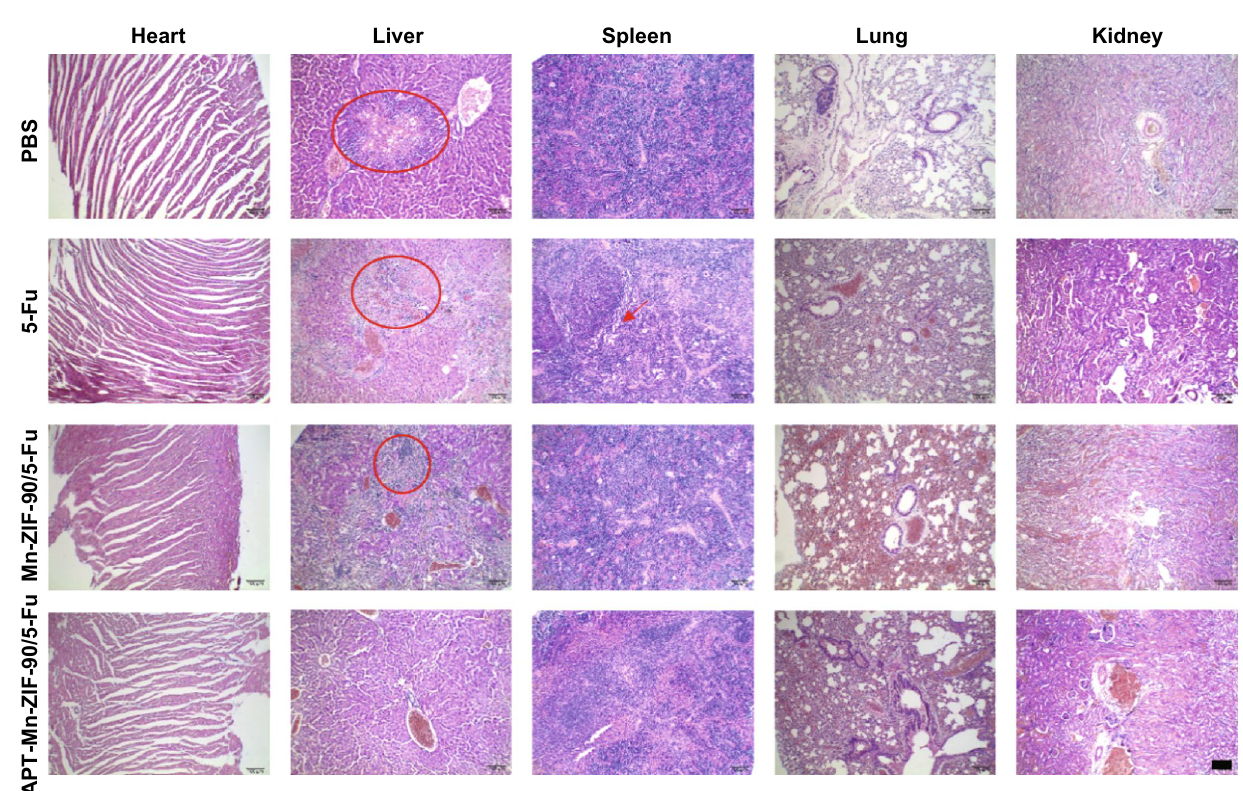
Fig. 8 H&E staining of major organs of MCF-7 tumor-bearing mice after treatment for 14 days. The metastasis are marked by the red cycle in the liver (scale bar = 100